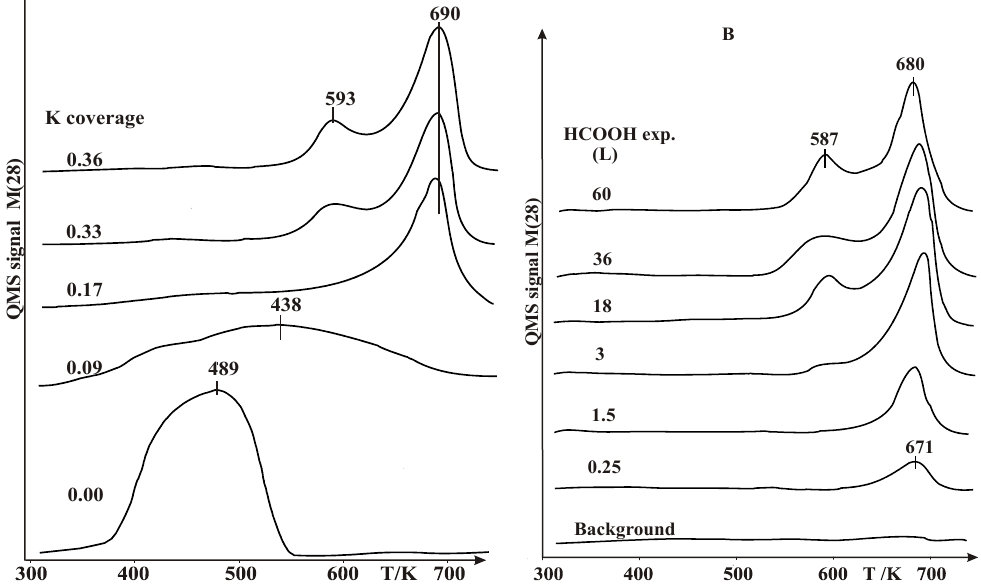
Figure 1. ( A ) Thermal desorption spectra of CO from different potassium covered Rh(111) FA exposure was 12 L. ( B ) Thermal desorption spectra of CO as a function of HCOOH exposure at monolayer K coverage ( Θ K = 0.3).